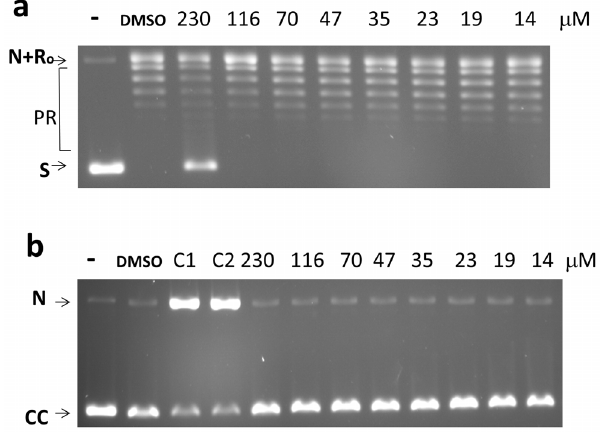
Figure 6. Effect of anziaic acid on type IB human topoisomer- ase I activity. (a) Assay of relaxation activity –1 U of enzyme was used in each relaxation reaction with 250 ng of supercoiled plasmid DNA. (b) DNA cleavage assay with 5 U of enzyme. Gel electrophoresis was carried out in the presence of 0.5 m g/mL ethidium bromide and camptothecin was used as a positive control at 62.5 m M (C1) or 125 m M (C2). -: no enzyme. S: supercoiled plasmid DN substrate. N: nicked plasmid DNA. Ro: Relaxed closed plasmid DNA. PR: partially relaxed plasmid DNA. CC: Covalently closed circular DNA.